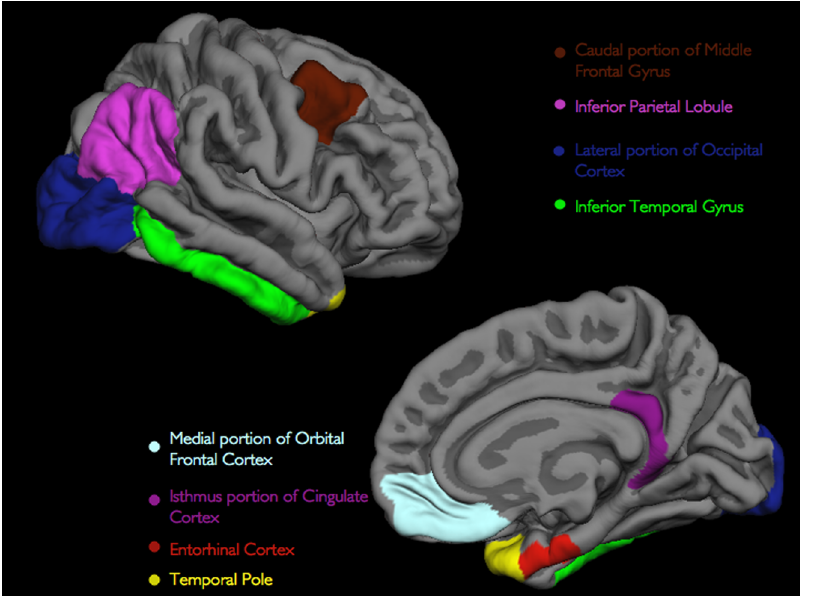
Figure 1. Three-dimensional representations of the 8 ROIs examined in the current study (only right hemisphere is shown). All of the ROIs visible in the lateral (top) and medial (bottom) views of the gray matter surface.